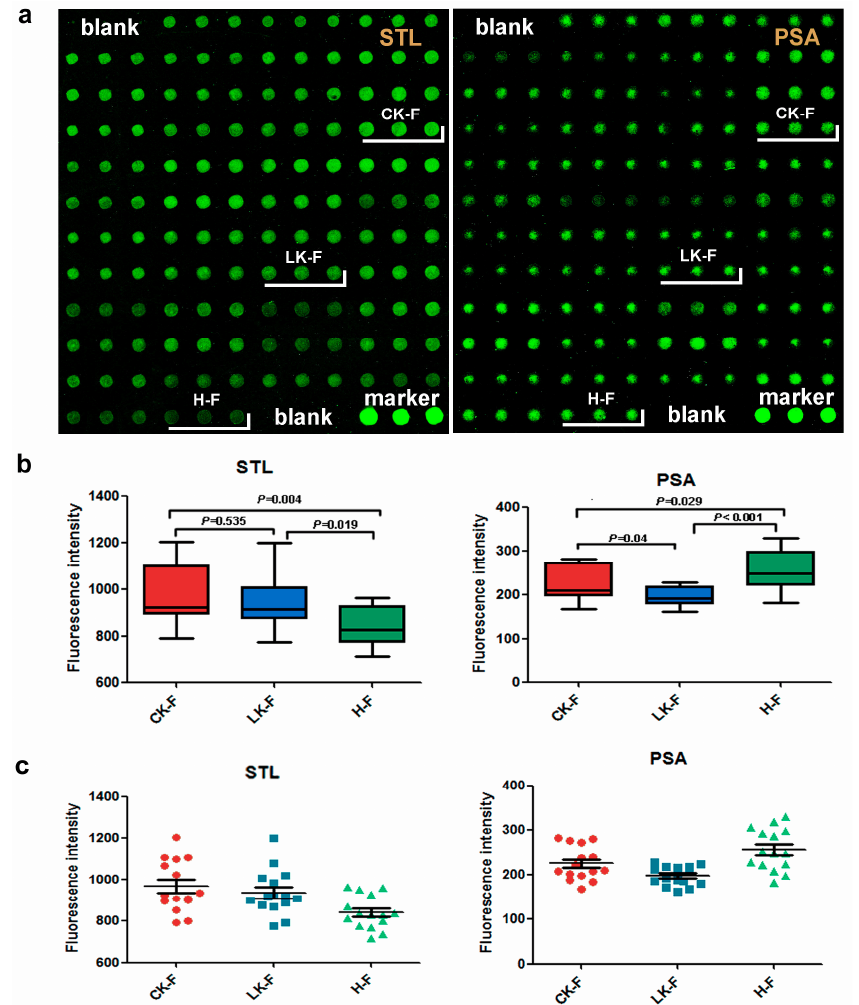
Figure 6. Validation of the binding of 2 lectins (STL and PSA) to serum glycoproteins. ( a ) Scanned images of Cy3-labeled lectins bound to the serum microarrays; ( b ) Box plot analysis of the data for the three groups obtained from the serum microarray. Error bars represent 95% confidence intervals for mean values. The statistical significance of differences between groups is indicated by the p -value. ( c ) Scatter plot analysis of the data for the six groups obtained from the saliva microarray. Lines represent mean ± SEM. CK-M: male patients with CKD, LK-M: male patients with LKD, H-M: male normal controls, CK-F: female patients with CKD, LK-F: female patients with LKD and H-F.